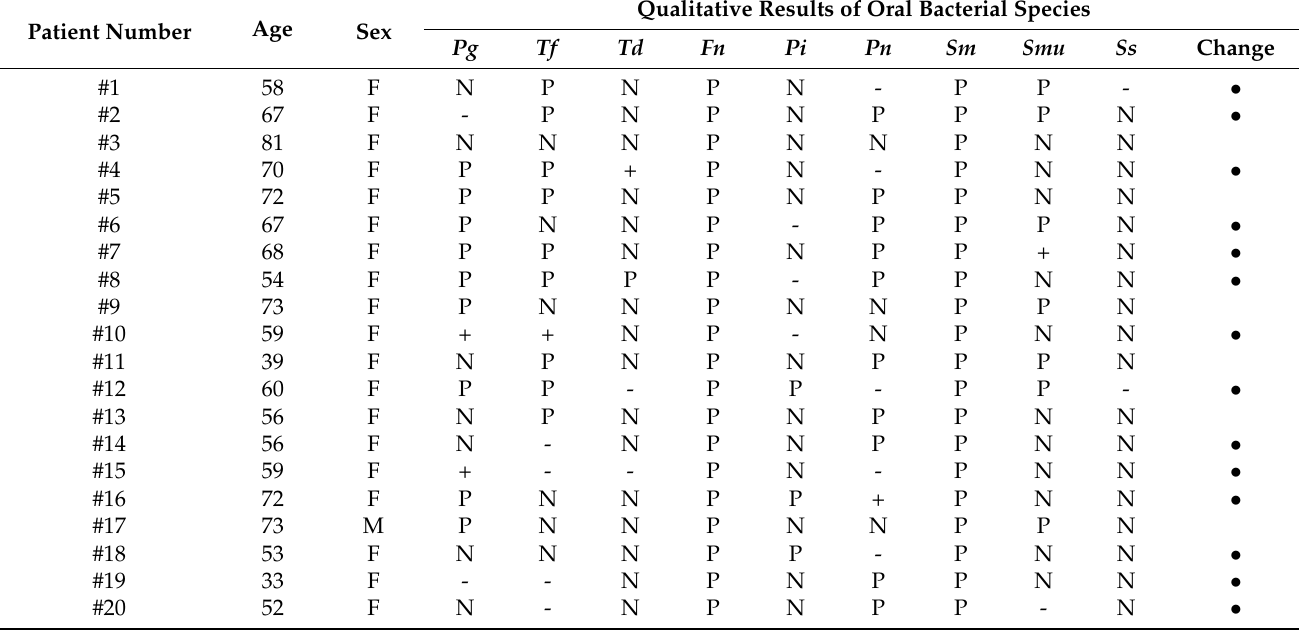
Table 1. Demographic information and qualitative changes in the oral bacterial species of the oral lichen planus patients before and after the treatment with dexamethasone gargle.